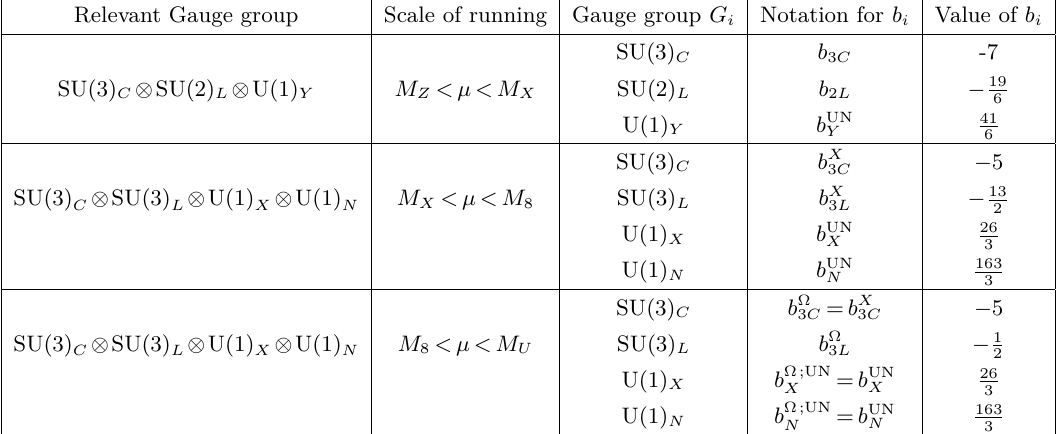
Table 2 . Values of b i for different gauge groups ( G i ) relevant for RG running of gauge couplings at different energy